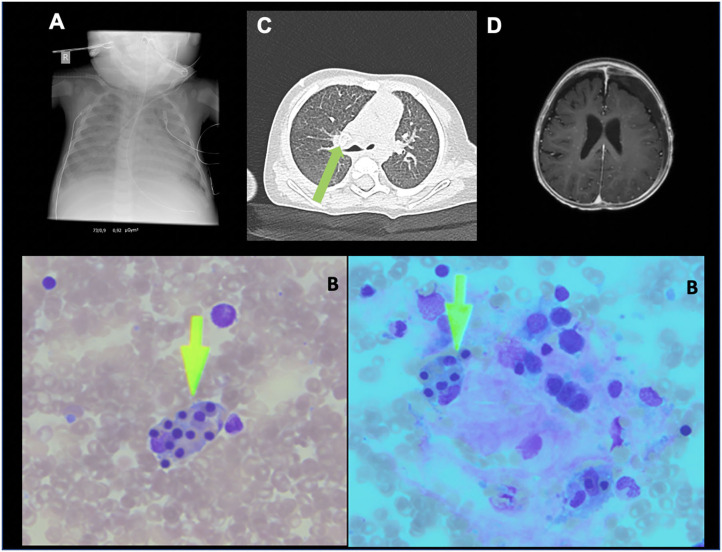
(A) patient's chest X-ray ad admission with acute respiratory distress syndrome, (B) bone arrow smear (Pappenheim stain) with hemophagocytosis (arrow), (C) patient's CT-scan after ECMO (day 30): calcified lymph node (arrow), (D) patient's MRI-scan after ECMO (day 42): small hygroma and CNS-miliary tuberculosis.